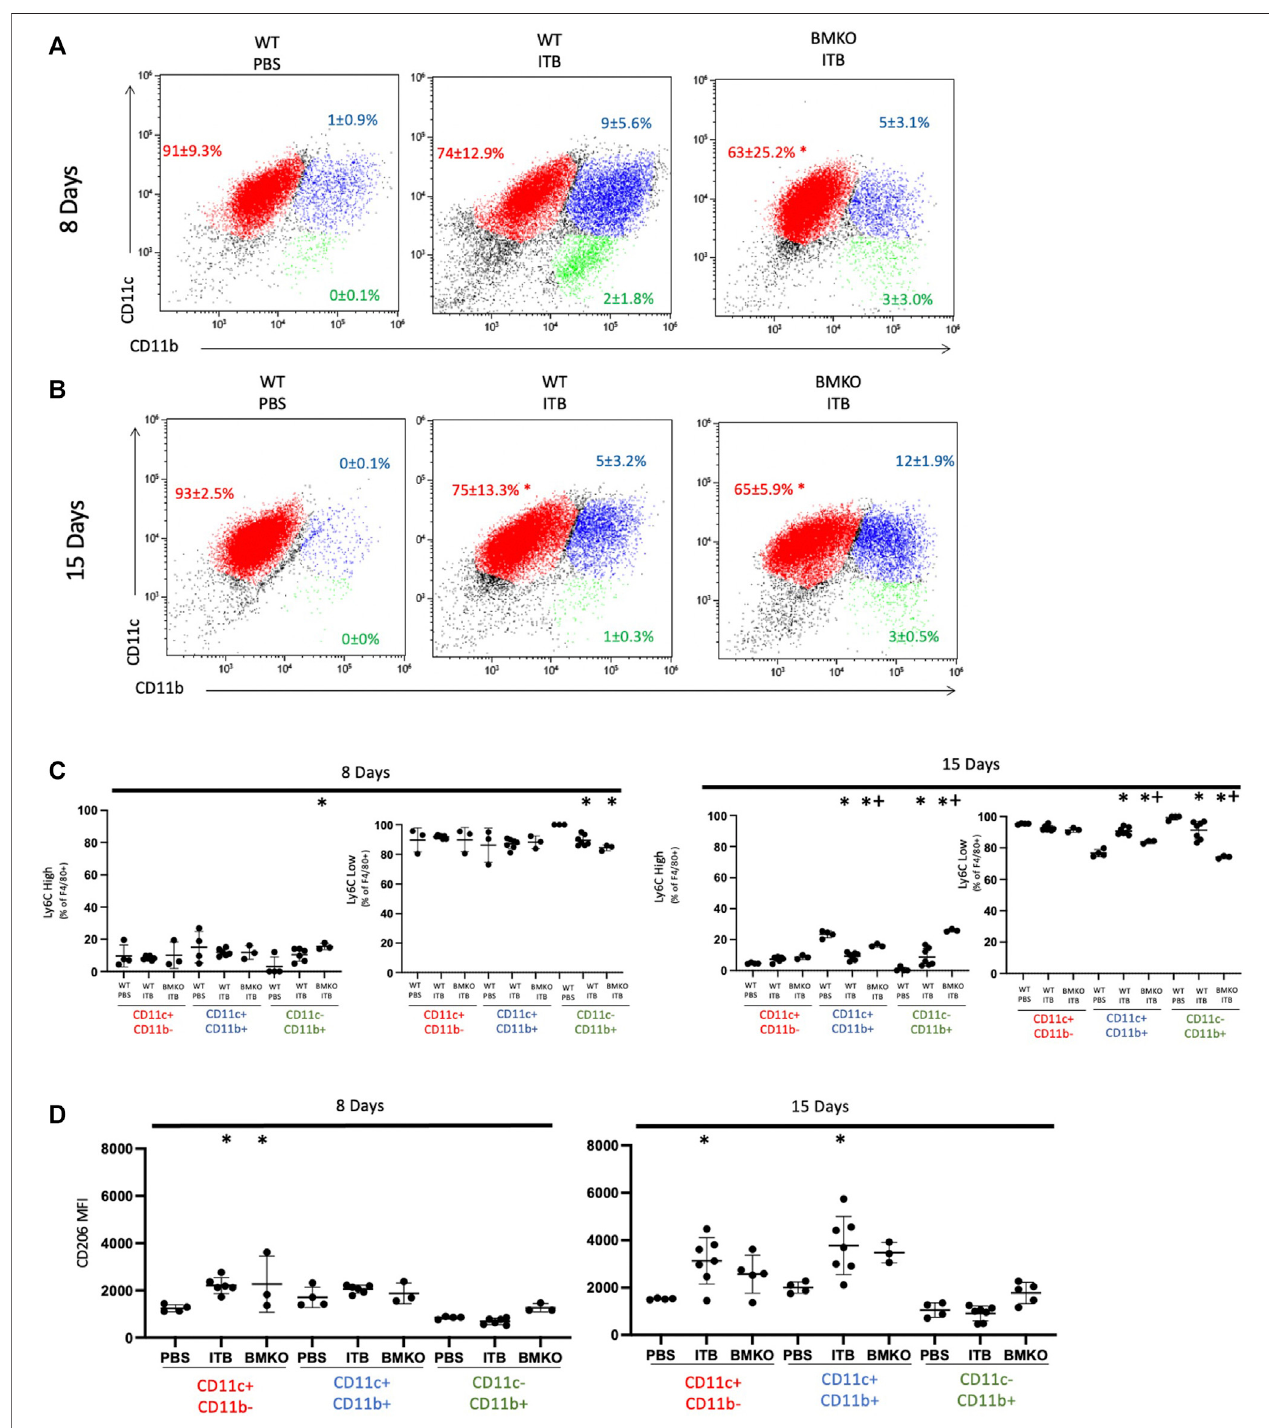
FIGURE 11 | Macrophage activation is in fl uenced by loss of iNOS in bone marrow derived cells. Macrophage maturity and activation in wild type and BMKO mice following ITB. (A – B) CD11c and CD11c expression on single live F4/80 + cells collected by bronchoalveolar lavage 8 (A) and 15 (B) days post ITB. (C – D) Expression of activation markers Ly6C (C) and CD206 (D) on sub-populations of macrophages. ( n = 3 – 7 per group) * p < 0.05 compared to PBS + p < 0.05 compared to ITB.